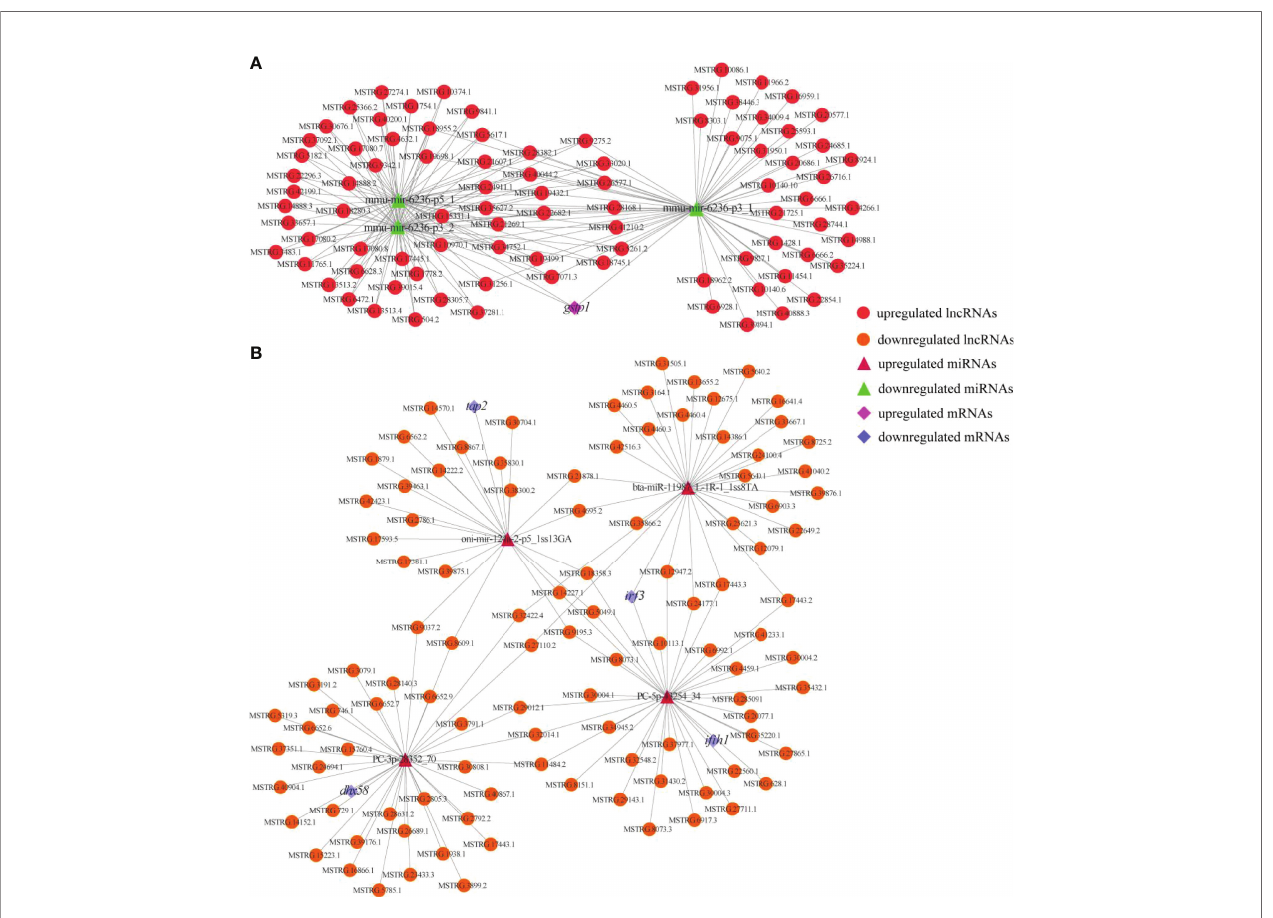
FIGURE 7 | Immune and metabolism-related DElncRNA-DEmiRNA-DEmRNA ceRNA networks. (A) A ceRNA network of metabolism-related gene. (B) A ceRNA network of immune-related genes. The red circles, green triangles and pink diamonds represent upregulated DElncRNAs, downregulated DEmiRNAs and upregulated DEmRNA, respectively. The yellow circles, wine red triangles and blue diamonds represent downregulated DElncRNAs, upregulated DEmiRNAs and downregulated DEmRNAs,